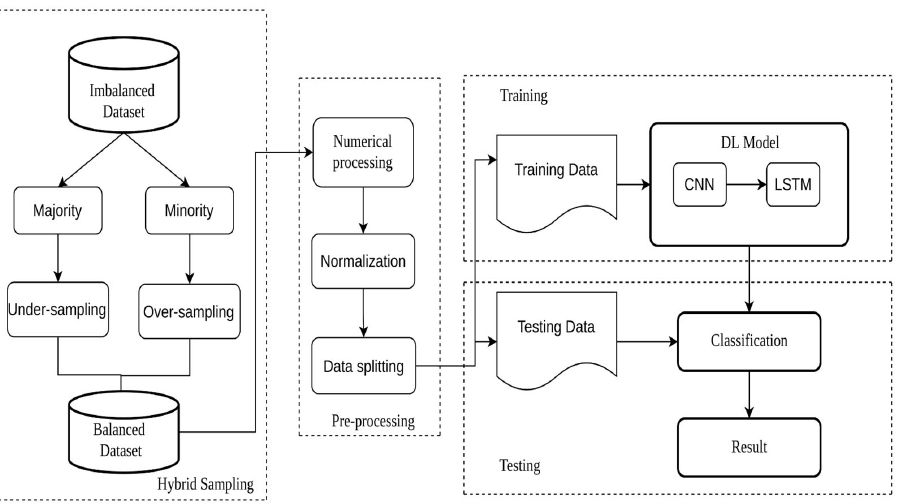
Figure 2. The flowchart of balancing the datasets and training the CNN ‐ LSTM model with balanced data.